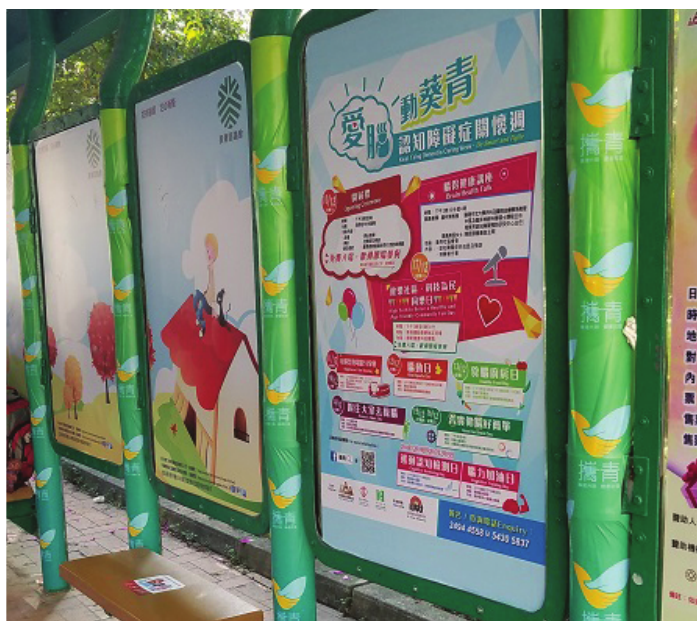
Figure A1. Priority seats at rain-shelters in Kwai Tsing District. Source: WHO Global Database of Age-friendly Practices